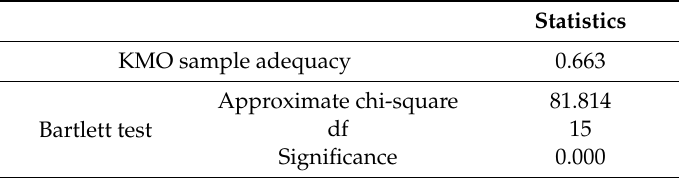
Table 10. KMO sample adequacy and Bartlett test.